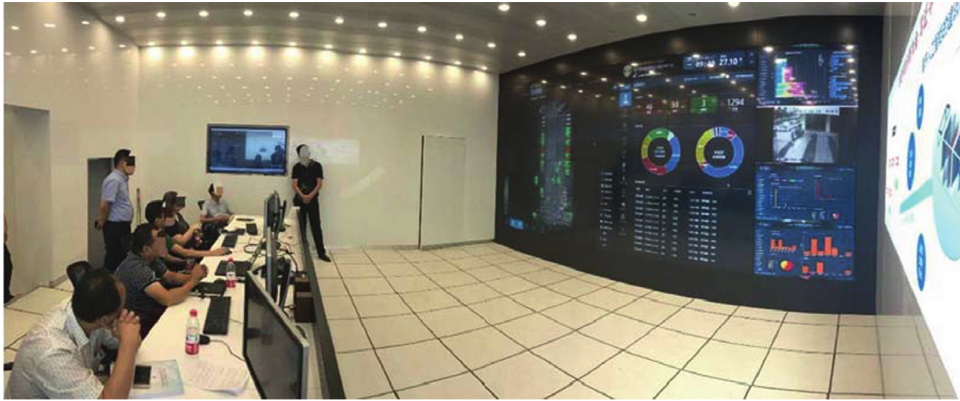
Figure 5: The main hall of the DT control